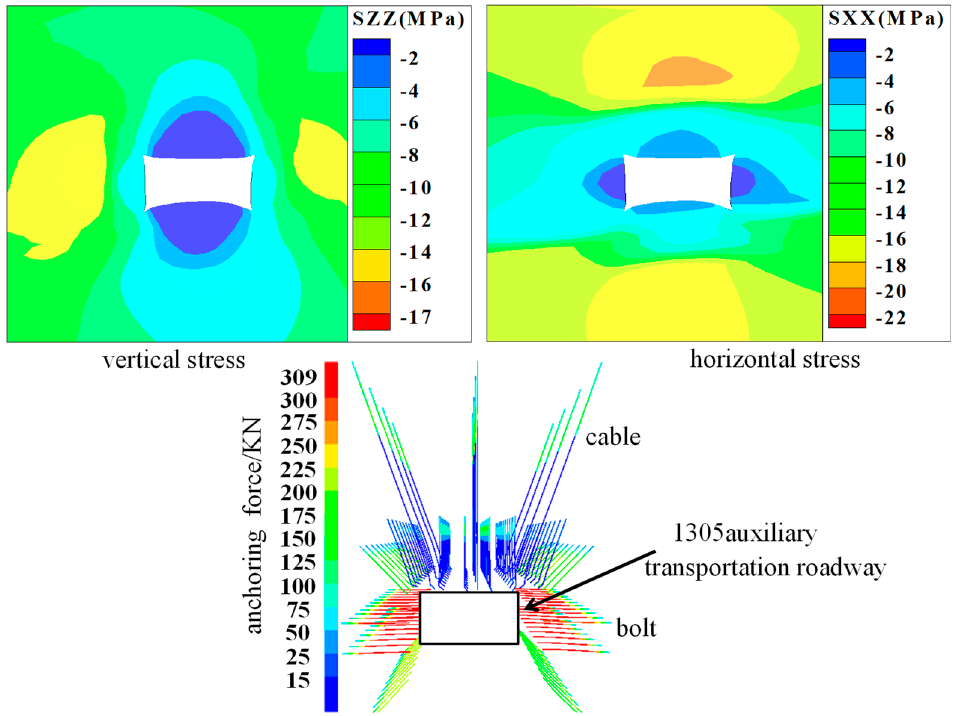
Figure 5. Contour of stress of surrounding rock and cable.